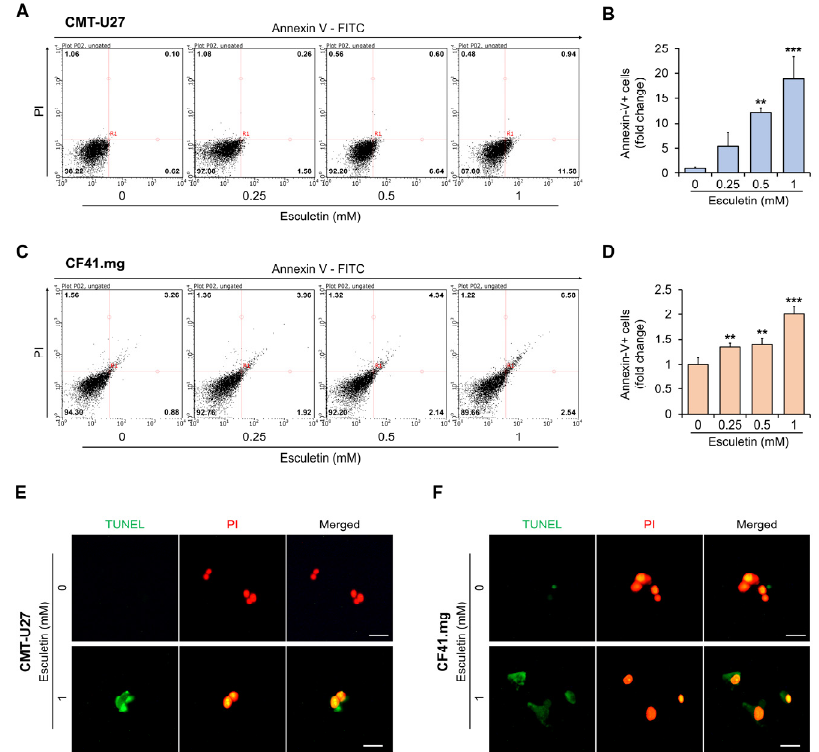
Figure 3. Esculetin induces apoptosis in CMT cells. ( A – D ) Flow cytometry analysis and quantification showing apoptosis in CMT-U27 ( A , B ) and CF41.mg ( C , D ) cells. ( E , F ) Fluorescent images showing an increase of TUNEL positive cells in CMT-U27 ( E ) and CF41.mg ( F ) cells. Scale bar, 25 μ m. Values are mean ± SD. ** p < 0.01, *** p < 0.001 versus untreated cells by one-way ANOVA followed by Bonferroni post-test.